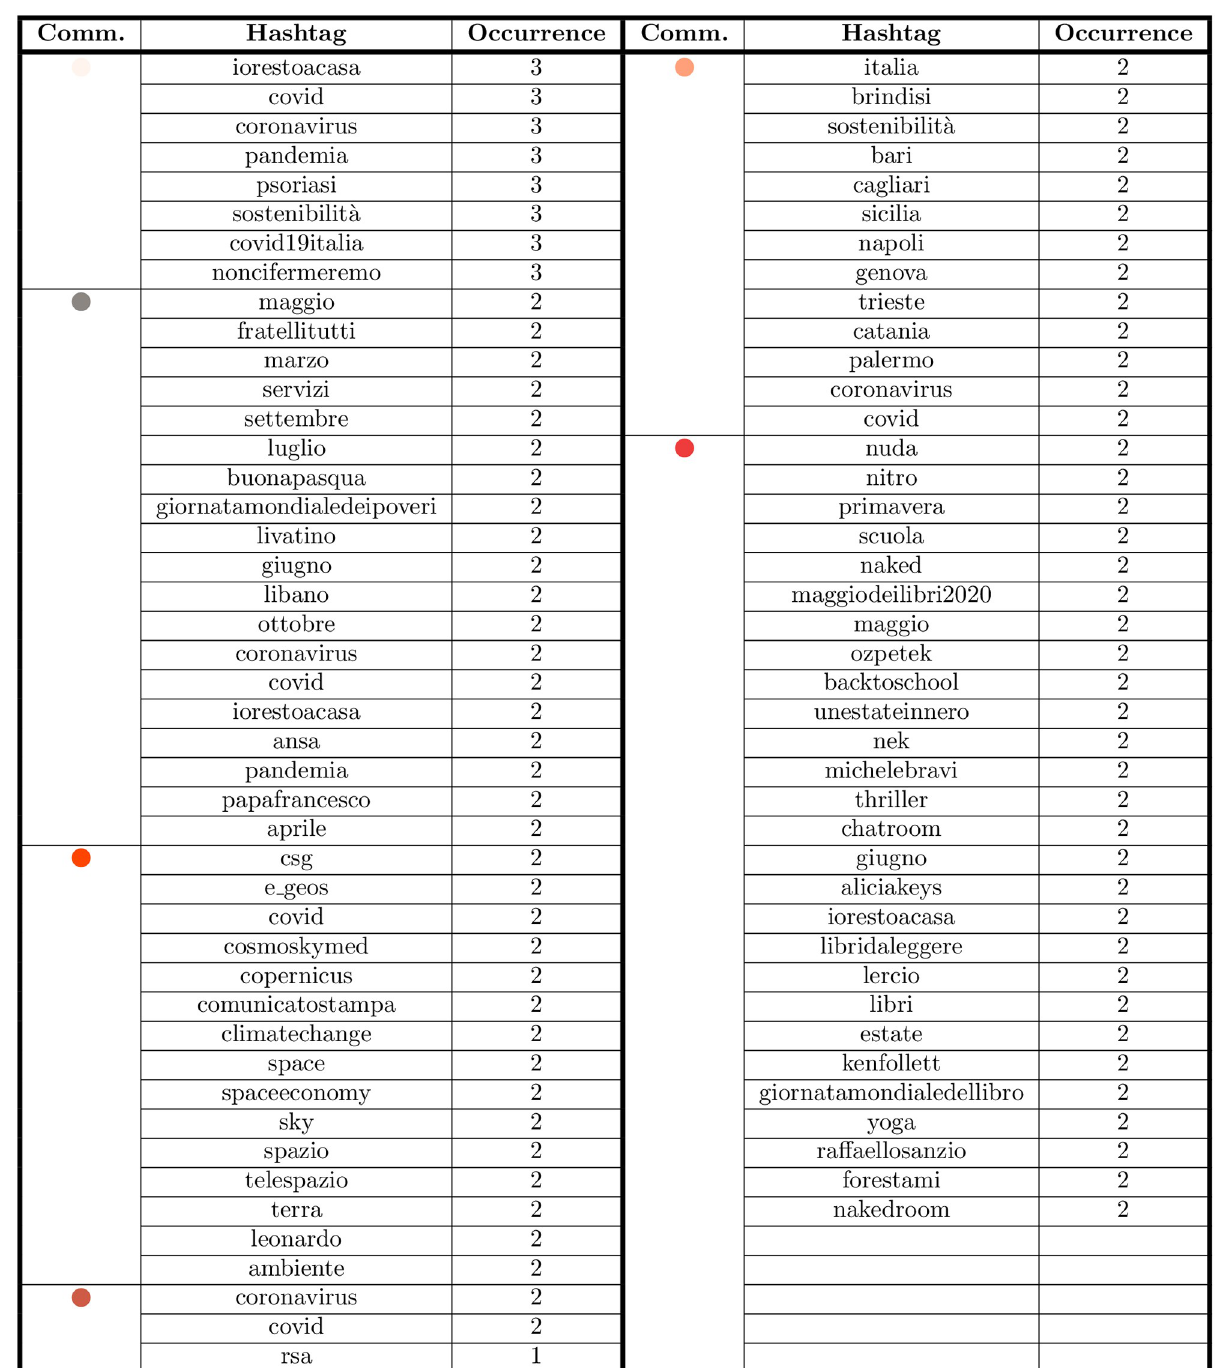
Fig 12. The top 5 frequent hashtag for the smaller communities of the network of Fig 2. Due to the great number of ex aequo , the top 5 most frequent hashtags is, in general, longer than 5.